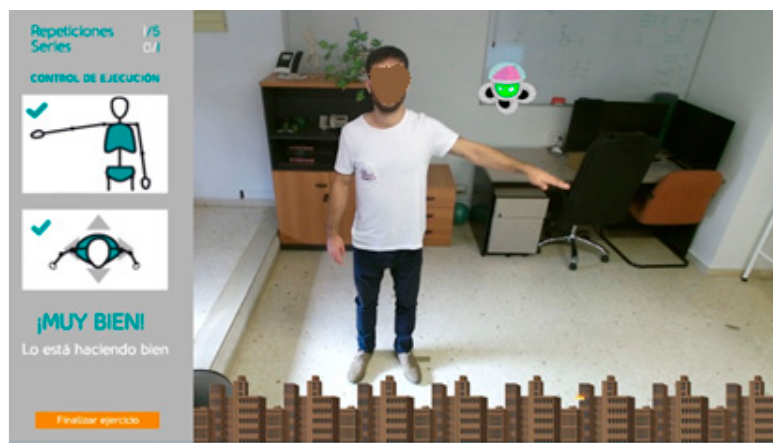
Figure 3. Gamified environment designed to encourage concentric exercises.